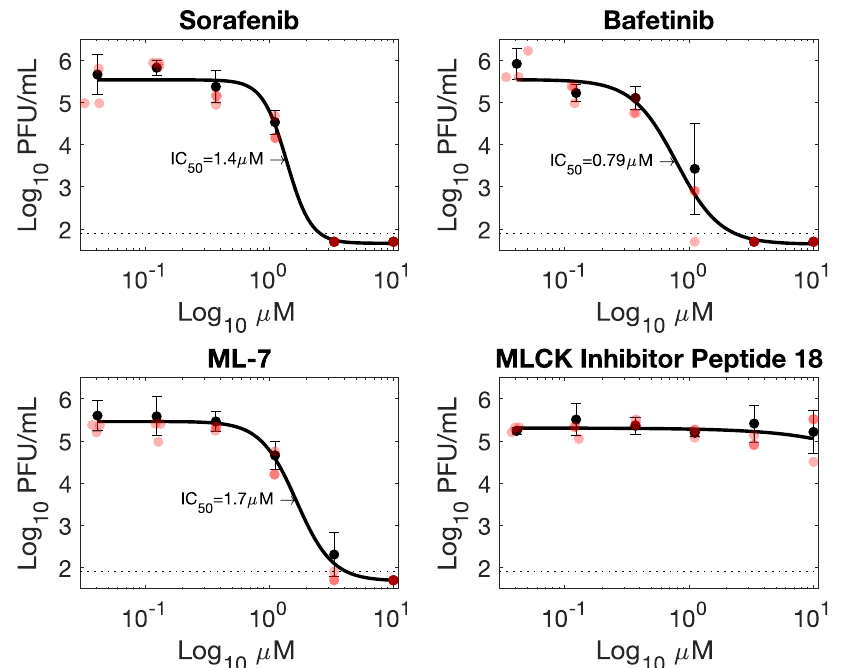
Fig. 6 Inhibitors targeting viral protease substrates reduce SARS-CoV-2 titres in A549-Ace2 cells. Sorafenib is a tyrosine kinase inhibitor previously shown to inhibit SARS-CoV-2 replication 4 . Bafetinib is a dual ABL/LYN inhibitor with off-target activity against SRC kinase. ML-7 and MLCK target myosin light chain kinase (MYLK/MLCK). Black circles and error bars represent mean and standard deviation. n = 3 biologically independent samples. Red circles indicate individual datapoints. The limit of detection in the plaque assay was calculated to be 40 PFU/mL (dotted line). PFU plaque-forming